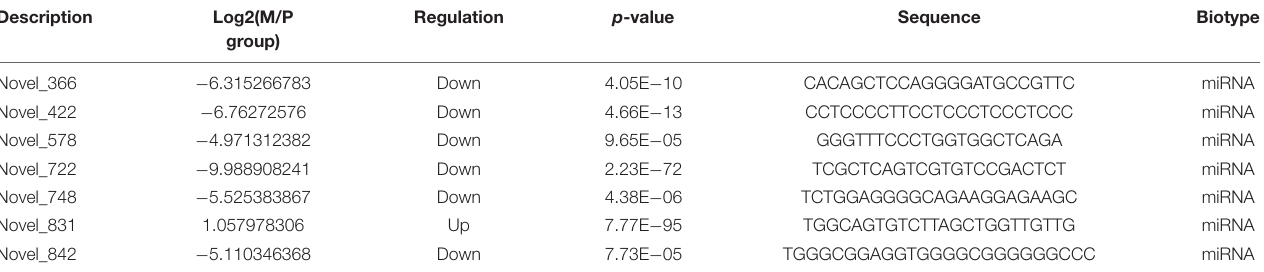
TABLE 5 | Core miRNAs of important networks in M group vs. P group of